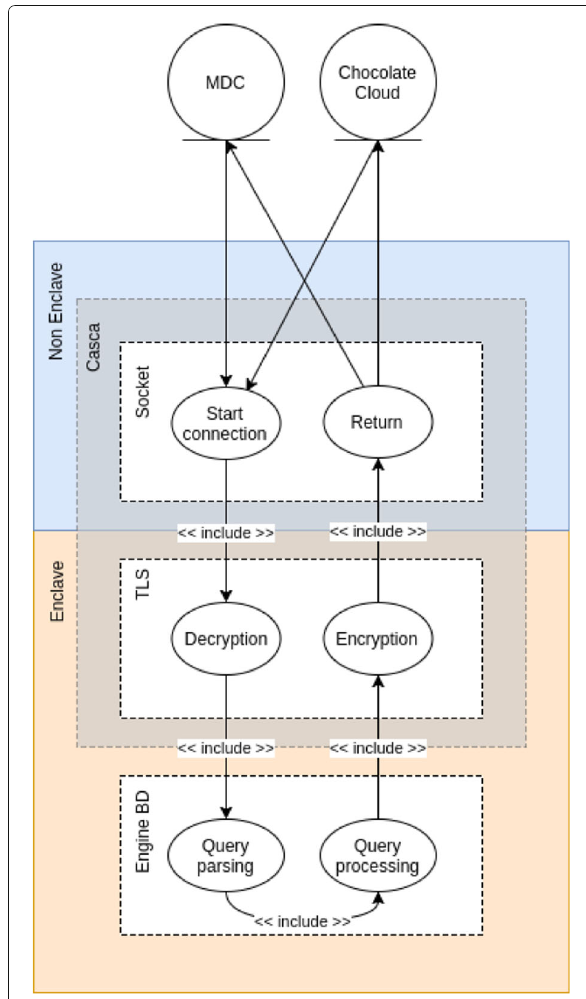
Fig. 7 CascaDB approach